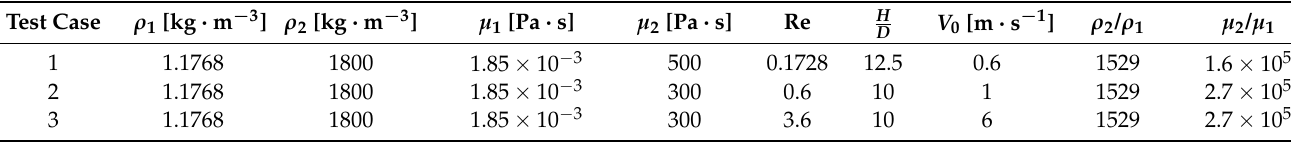
Table 4. Physical parameters describing the test cases. Here, ρ 2 and µ 2 refer to the propergol density and viscosity respectivly, ρ 1 and µ 1 , refer to the density and viscosity of the gas respectivly, Re = ρ 2 DV 0 to the propergol, H is the aspect ratios of the jet and V 0 is the inlet velocity. In the present work, propergol (fluid 2) is D assumed to behave like a Newtonian fluid, for the sake of